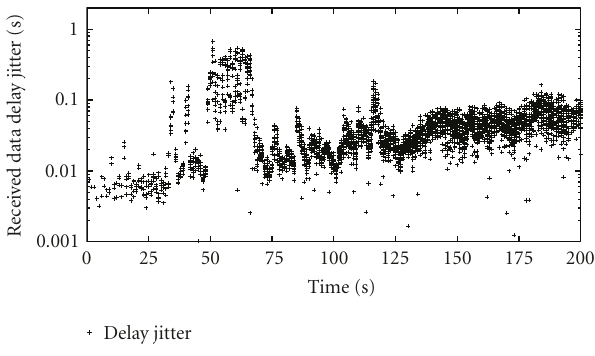
Figure 15: Delay jitter per session at node